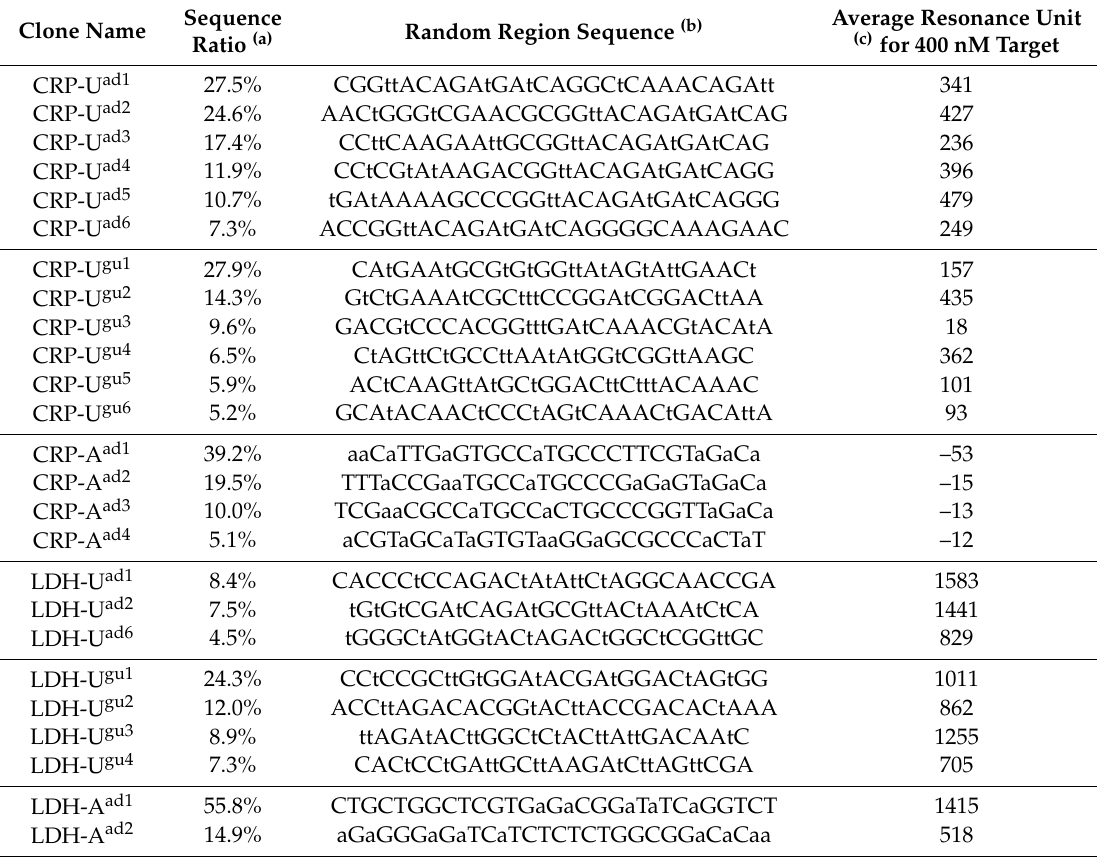
Table 1. The sequences from the U ad -, U gu -, and A ad -modified single strand DNA library that target binding assessment was performed using surface plasmon resonance